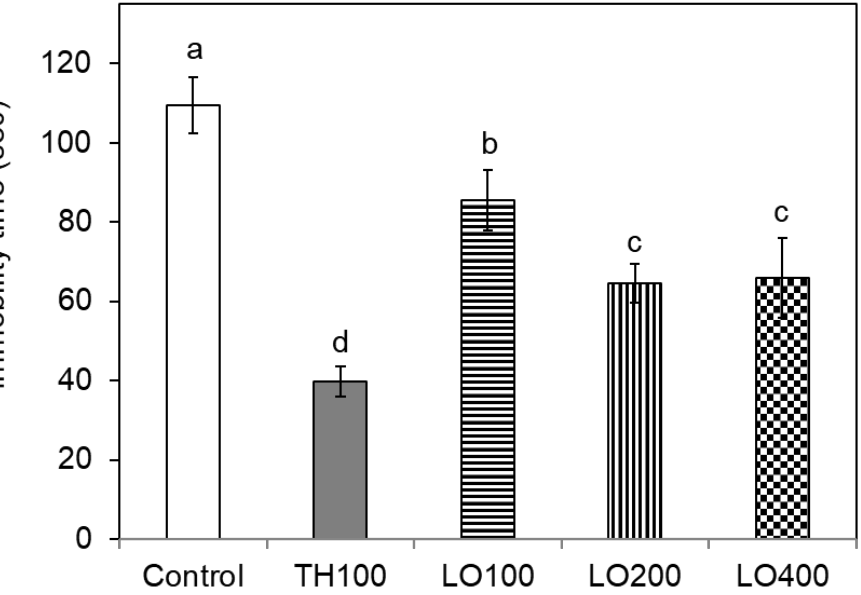
Figure 3. Effect of different doses of C. osmophloeum ct. linalool leaf oil on antidepressant activity in ICR mice by the forced swimming assay. Data are presented as mean ± S.D. ( n = 7); TH100: trazodone hydrochloride, 100 mg/Kg; LO100, LO200, and LO400: leaf oil, 100 mg/Kg, 200 mg/Kg, and 400 mg/Kg. Different letters (a–d) in the figure are significantly different at the level of p < 0.05 according to the Scheffe’s test.